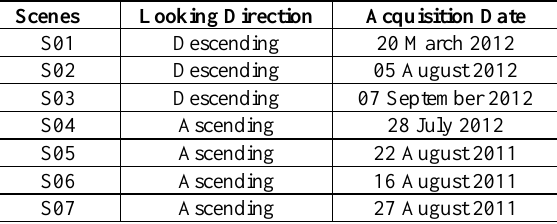
Table 3. TerraSAR-X(TSX) / TanDEM-X(TDX) Data